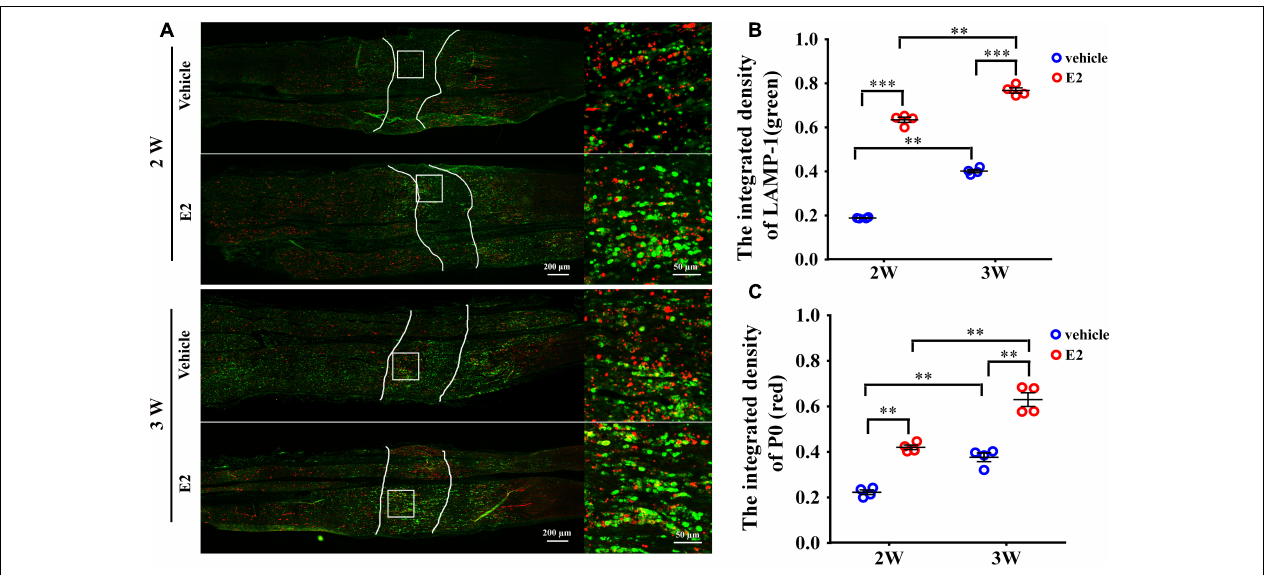
FIGURE 8 | E2 increased the number of lysosomes containing myelin protein P0 in regeneration sciatic nerve. (A) Immunohistochemistry with anti-LAMP1 (green) and anti-P0 (red), obtained at 2 and 3 weeks after surgery, of the regenerating nerve in OVX rats with E2 or vehicle treatment. Also shown are the higher magnifications of the boxed areas. It is worth noting that P0 has high colocalization ratio with LAMP1 in E2-treated group. Scale bars, 200 µ m; zoom in, 50 µ m. (B,C) The expression of lysosome membrane protein LAMP1 and myelin protein P0 in the regenerating region of E2-treated group was significantly higher than vehicle group. ∗∗ p < 0.01, ∗∗∗ p < 0.001 versus vehicle. Two-way ANOVA, n = 12 slices from 4 rats per group. All the data are mean ±